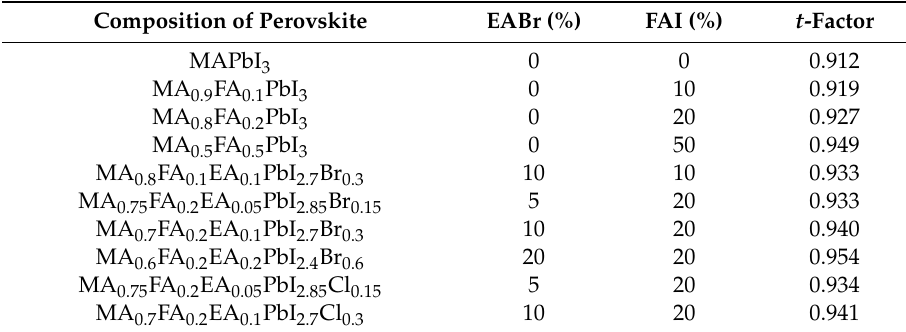
Table 1. Compositions and calculated t -factors of the present perovskite compounds. Composition of Perovskite